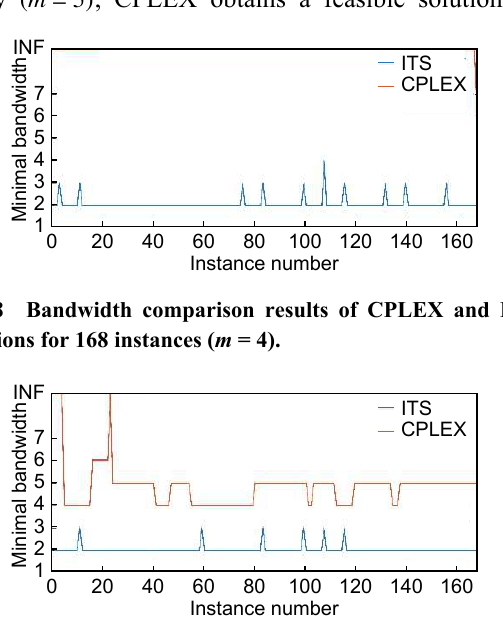
Fig. 9 Bandwidth comparison results of CPLEX and ITS solutions for 168 instances ( m =